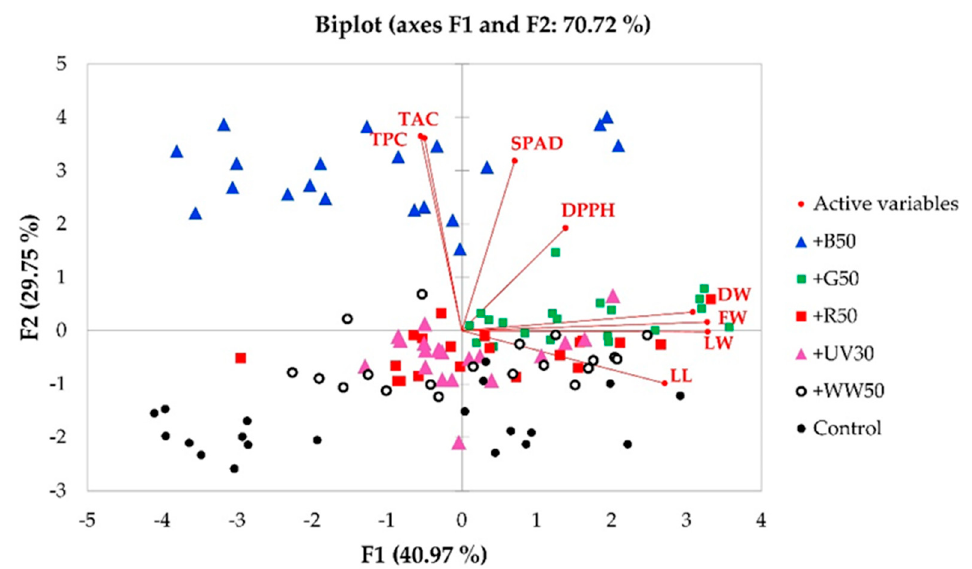
Figure 3. A principal component analysis biplot, indicating distinct effects of lighting treatments on ‘Rouxai’ baby-leaf lettuce and correlations between growth, morphological, and biochemical measurements. LL—leaf length; LW—leaf width; FW—fresh weight; DW—dry weight; DPPH—2.2–Diphenyl–1–picrylhydrazyl free radical scavenging activity; TPC—total phenolic content; TAC—total anthocyanin content. See Table S2 for the description of